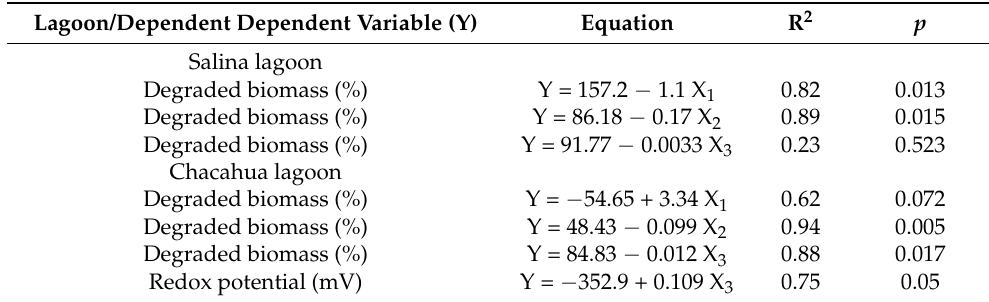
Table 2. Simple linear regression analysis of leaf degradation rate (%) with chemical parameters in mangrove forests bordering the Chacahua and Salina lagoons, Oaxaca, where X 1 (salinity in UPS), X 2 (redox potential in mV), and X 3 (sulfates in mg/L) with a significance level of p < 0.05. Lagoon/Dependent Dependent Variable (Y) Equation R 2 p Salina lagoon Degraded biomass (%) Y = 157.2 − 1.1 X 1 0.82 0.013 Degraded biomass (%) Y = 86.18 − 0.17 X 2 0.89 0.015 Degraded biomass (%) Y = 91.77 − 0.0033 X 3 0.23 0.523 Chacahua lagoon Degraded biomass (%) Y = − 54.65 + 3.34 X 1 Degraded biomass (%) Y = 48.43 − 0.099 X 2 Degraded biomass (%) 0.75